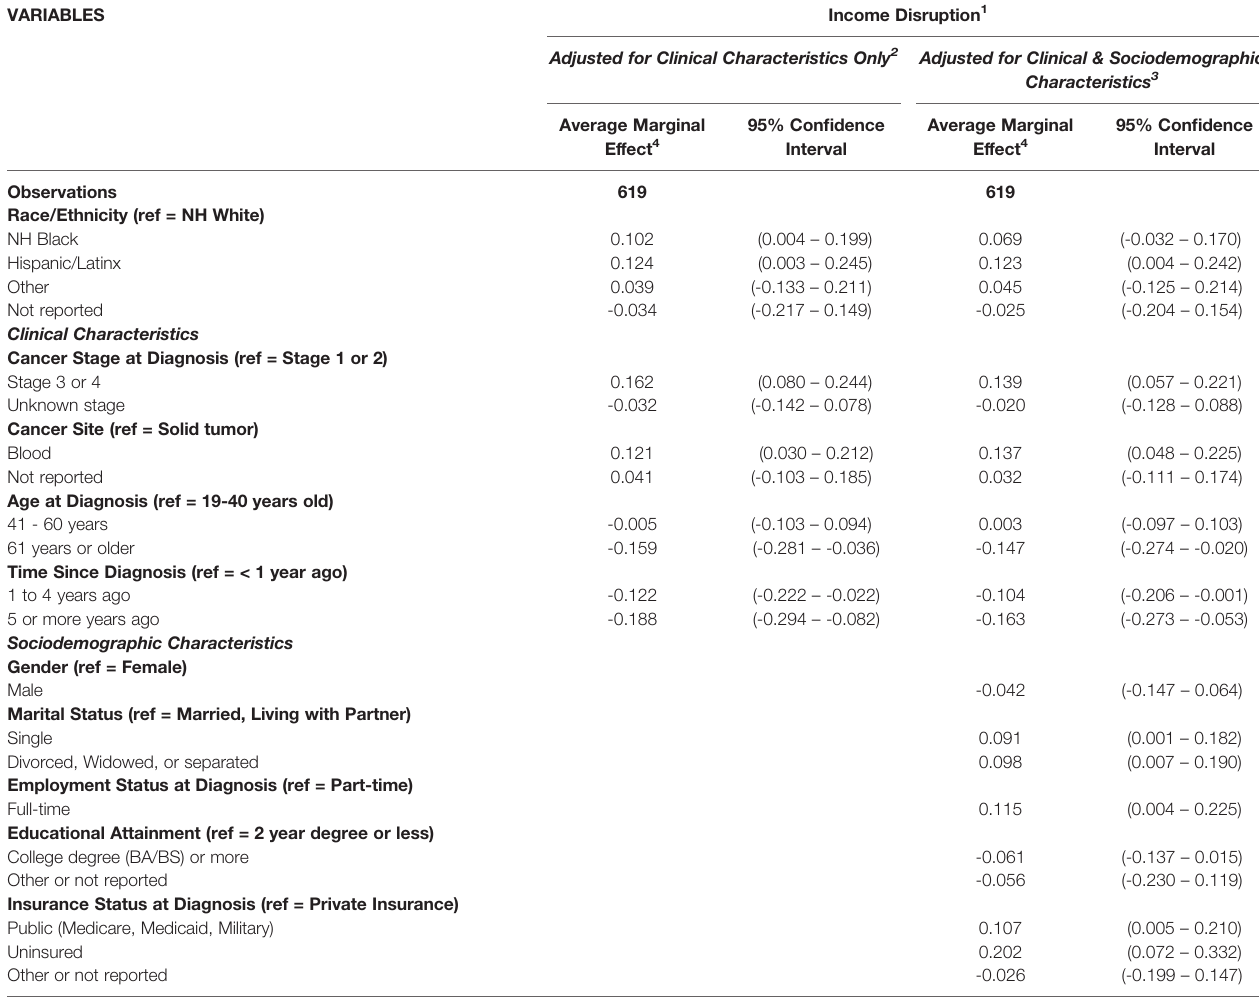
TABLE 2 | Multivariable associations between patient characteristics and household income loss in a sample of employed patients with cancer who received assistance from a national non-pro fi t (Oct – Nov 2019).